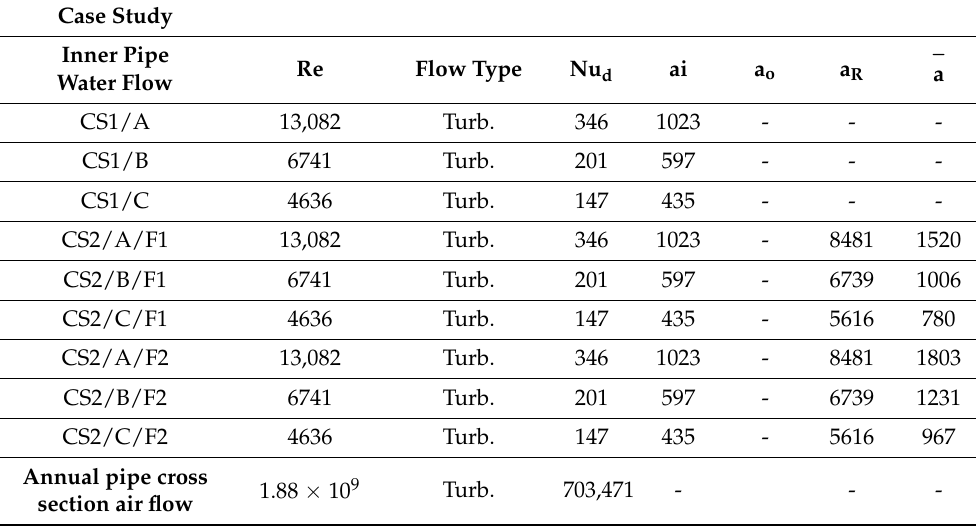
Table 6. Convective heat transfer calculations.